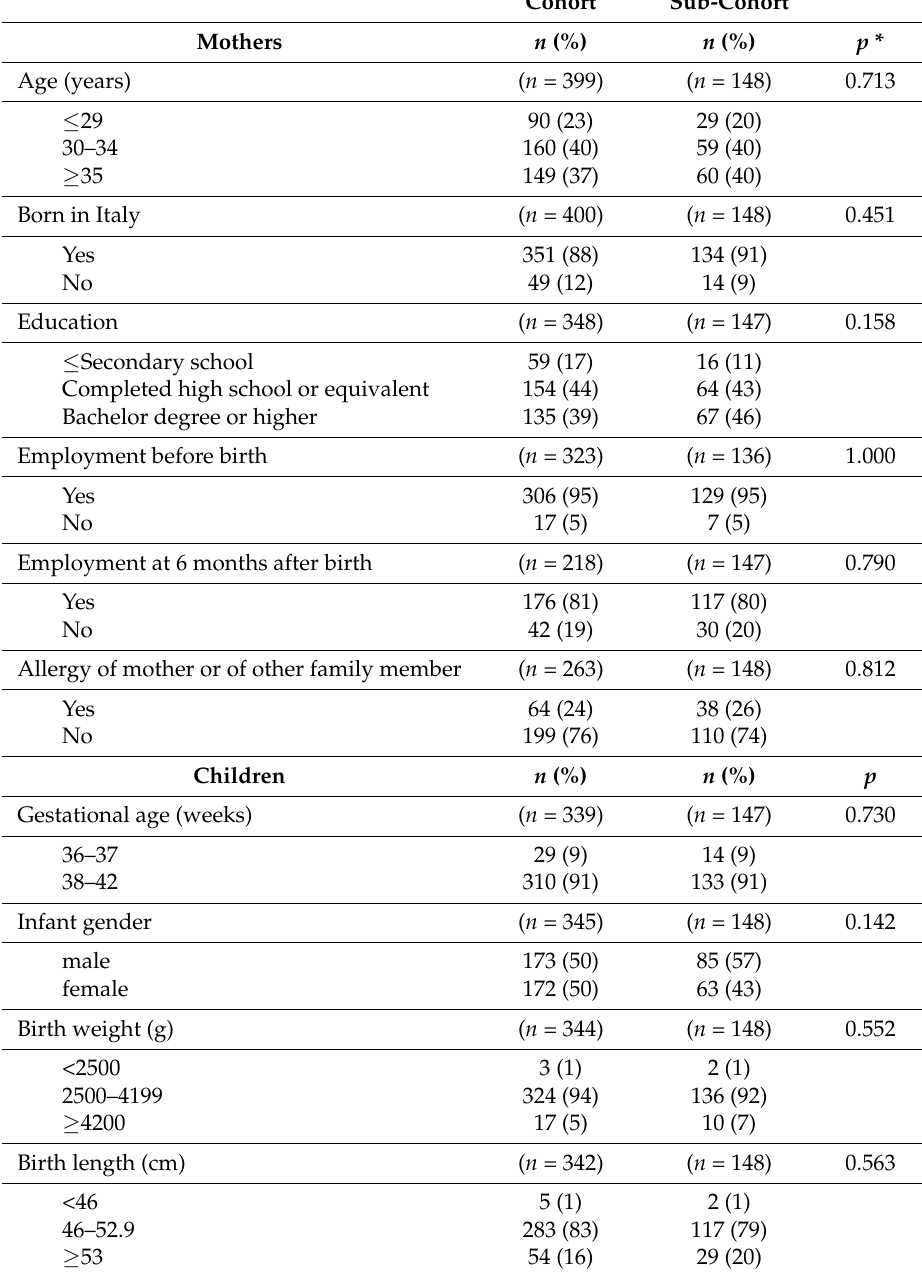
Table 1. Characteristics of mothers at enrolment and children at